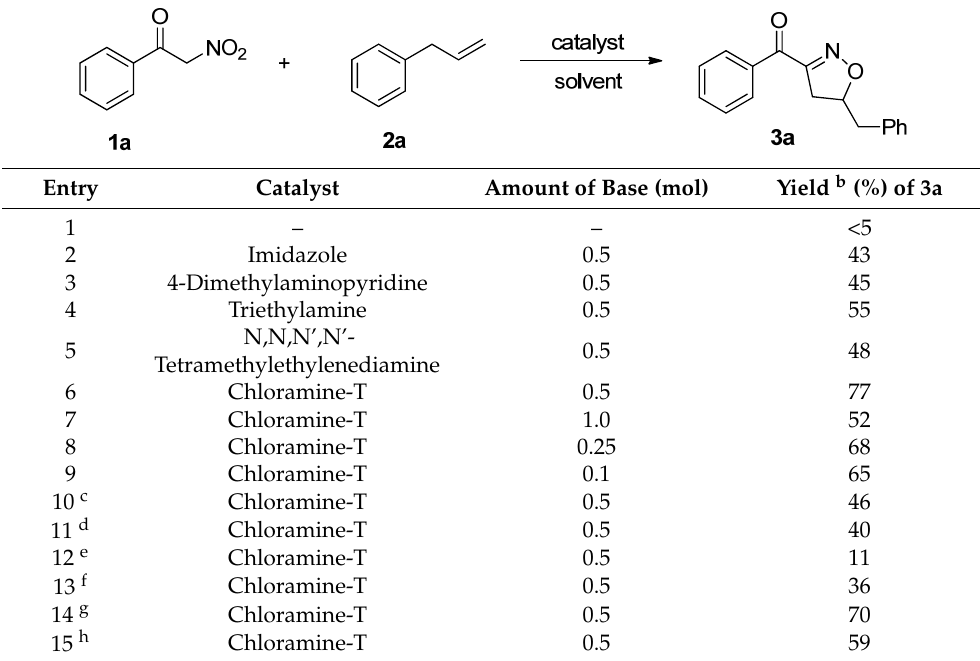
Table 1. Reaction condition optimization a .